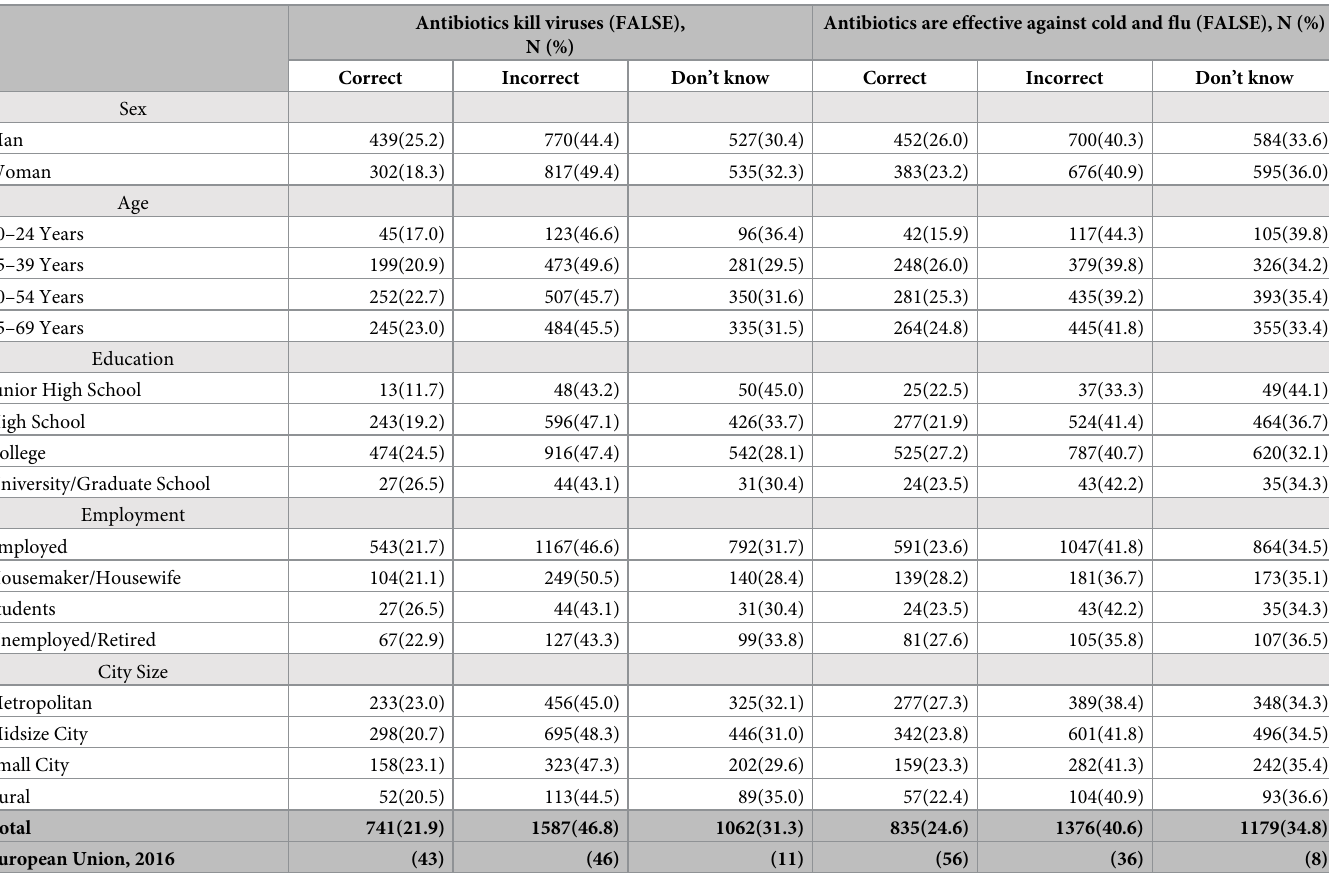
Table 3. Knowledge about antibiotic